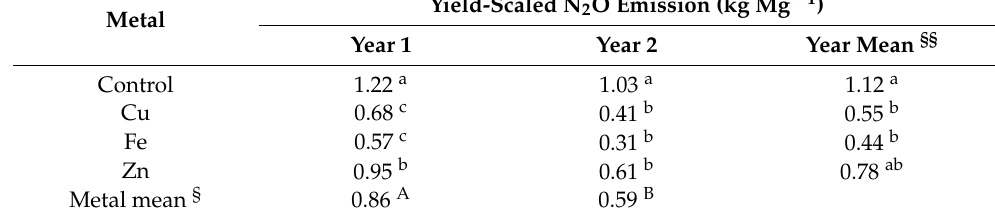
Metal application significantly affected NH 4+ and NO 3 − concentrations in soil at harvest (Table 3). Mean values of cumulative N 2 O emission across years from